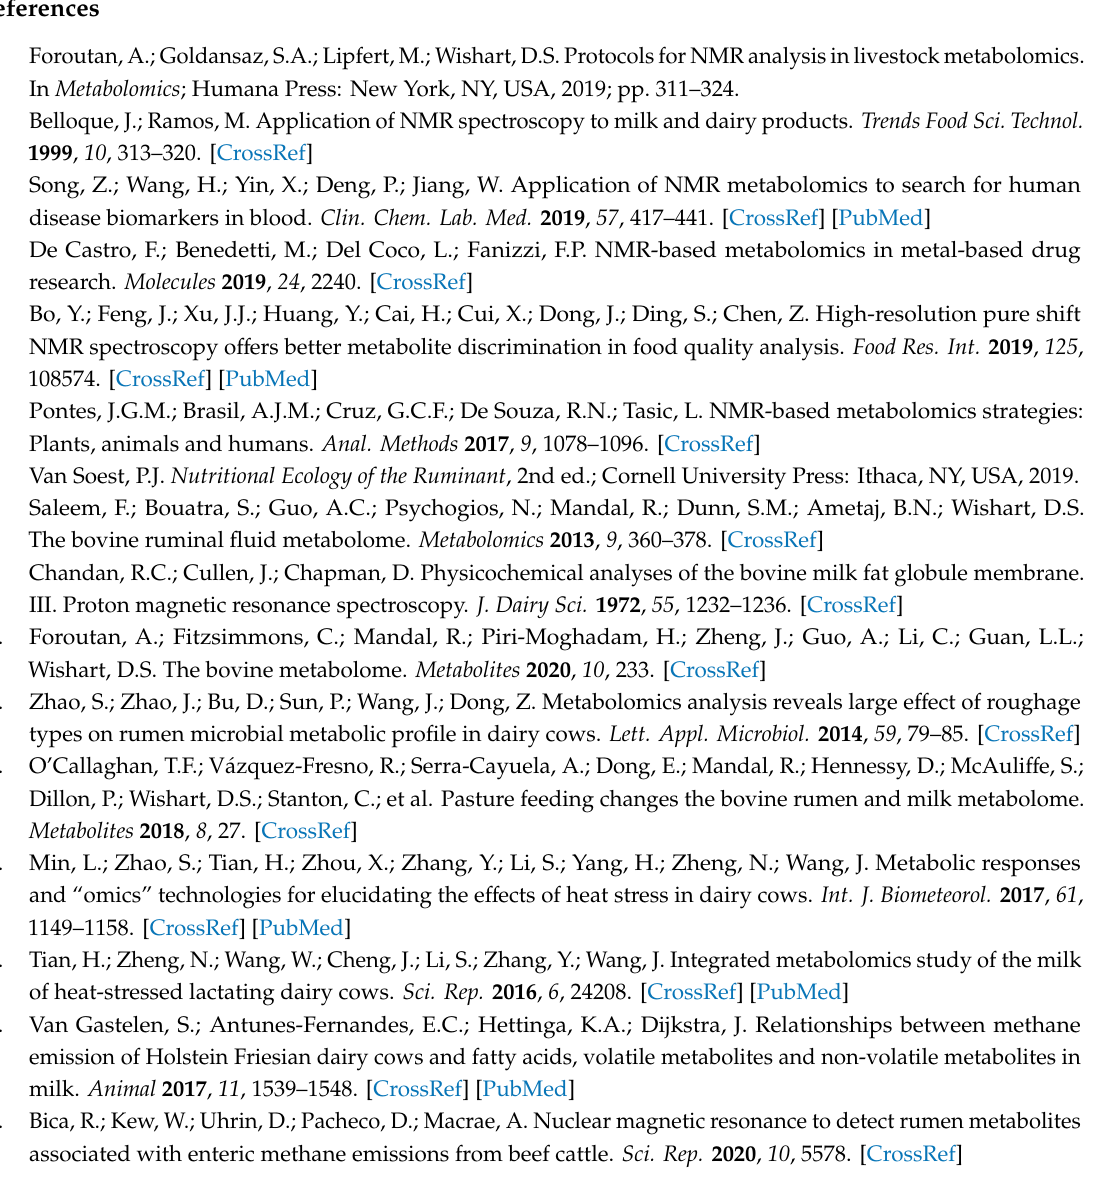
The abscissa and ordinate represent the variance associated with PC1 and 2, respectively, Figure S3: Partial least square discriminant analysis (PLS-DA) score plot of rumen fluid, serum, and urine by 1 H-NMR spectroscopy analysis. The shaded ellipses represent the 95% confidence interval estimated from the score. On the score plot, each point represents an individual sample, with the red dot representing the rumen fluid group ( n = 6), green dot representing the serum group ( n = 6), and blue dot representing urine group ( n = 4). The abscissa and ordinate represent the variance associated with component 1 and 2,